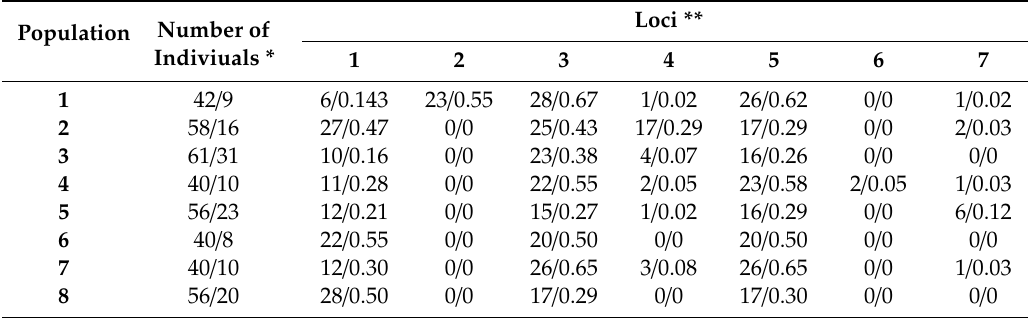
Table 1. Population analysis of the frequency of the occurrence of various variants of 5 (cid:48) -truncated copies of R2 retrotransposons of B.